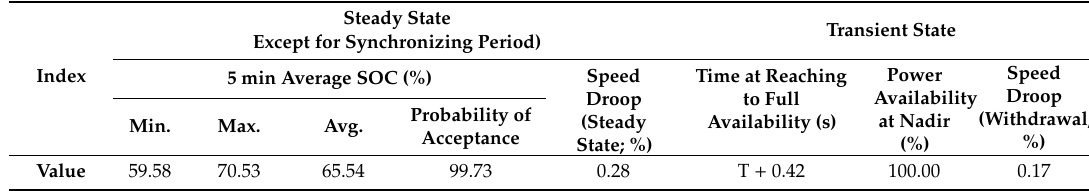
Table 8. Verification result from the long-term simulation.